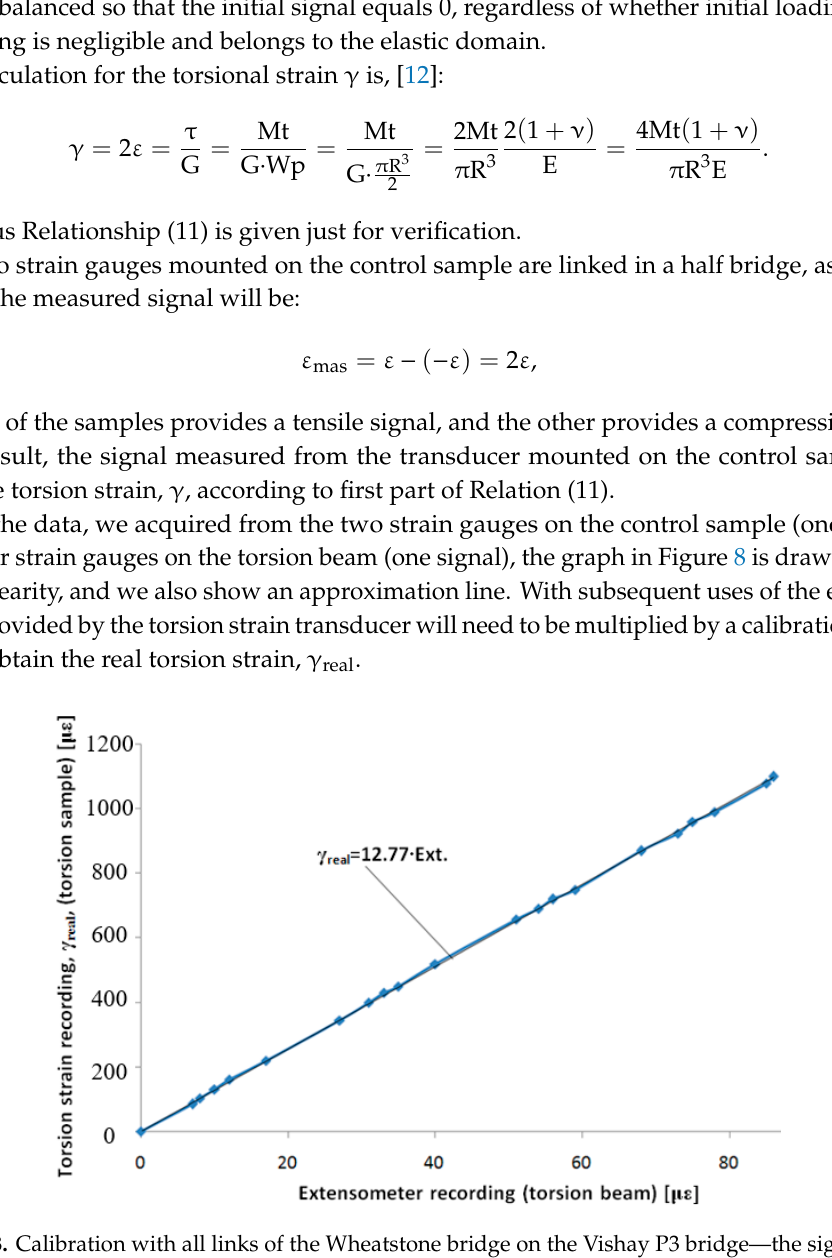
Figure 8. Calibration with all links of the Wheatstone bridge on the Vishay P3 bridge—the signal from the extensometer is in με .